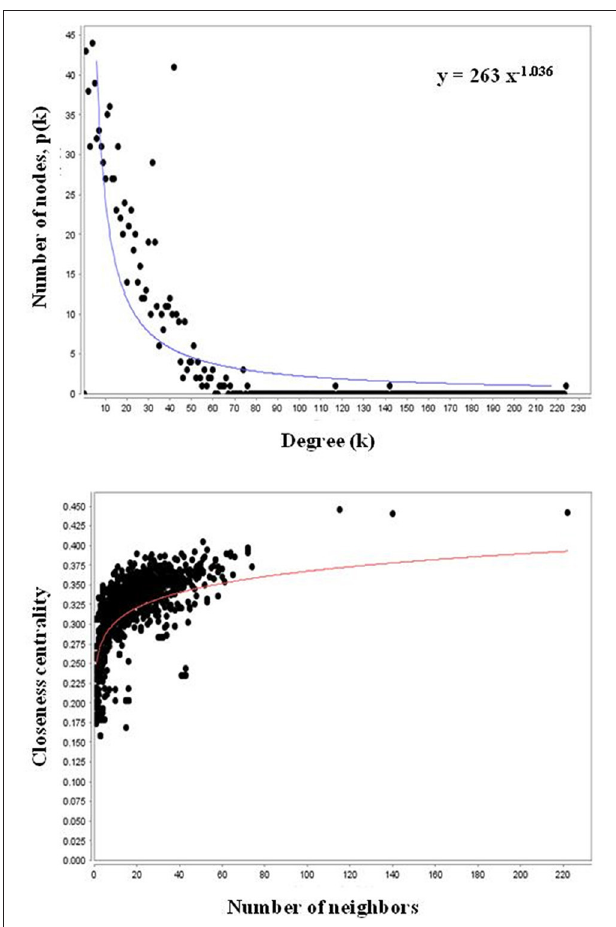
FIGURE 3 | Scale-free nature of degree and closeness centrality distributions of PGN. The distributions of degree and closeness centrality show a scale-free